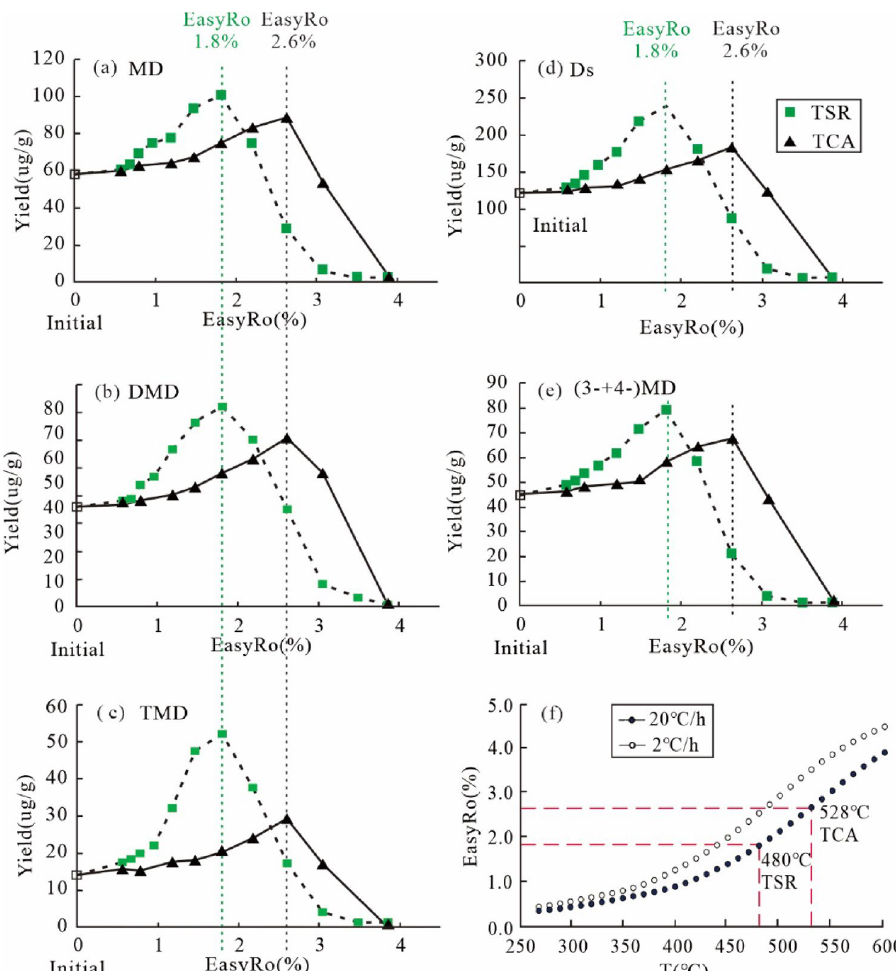
Figure 5. Plots showing the correlation of EasyRo (%) or heating temperature (°C) with the yields of different types of diamantanes (µg/g oil) in the TSR experiments (Group1) and TCA experiments: ( a ) MD versus EasyRo, ( b ) DMD versus EasyRo, ( c ) TMD versus EasyRo; ( d ) Ds versus EasyRo; ( e ) (3- + 4-)MD versus EasyRo ( f ) heating temperature versus EasyRo. MD = methyldiamantanes; DMD = dimethyldiamantanes; TMD = trimethyldiamantanes; Ds = total